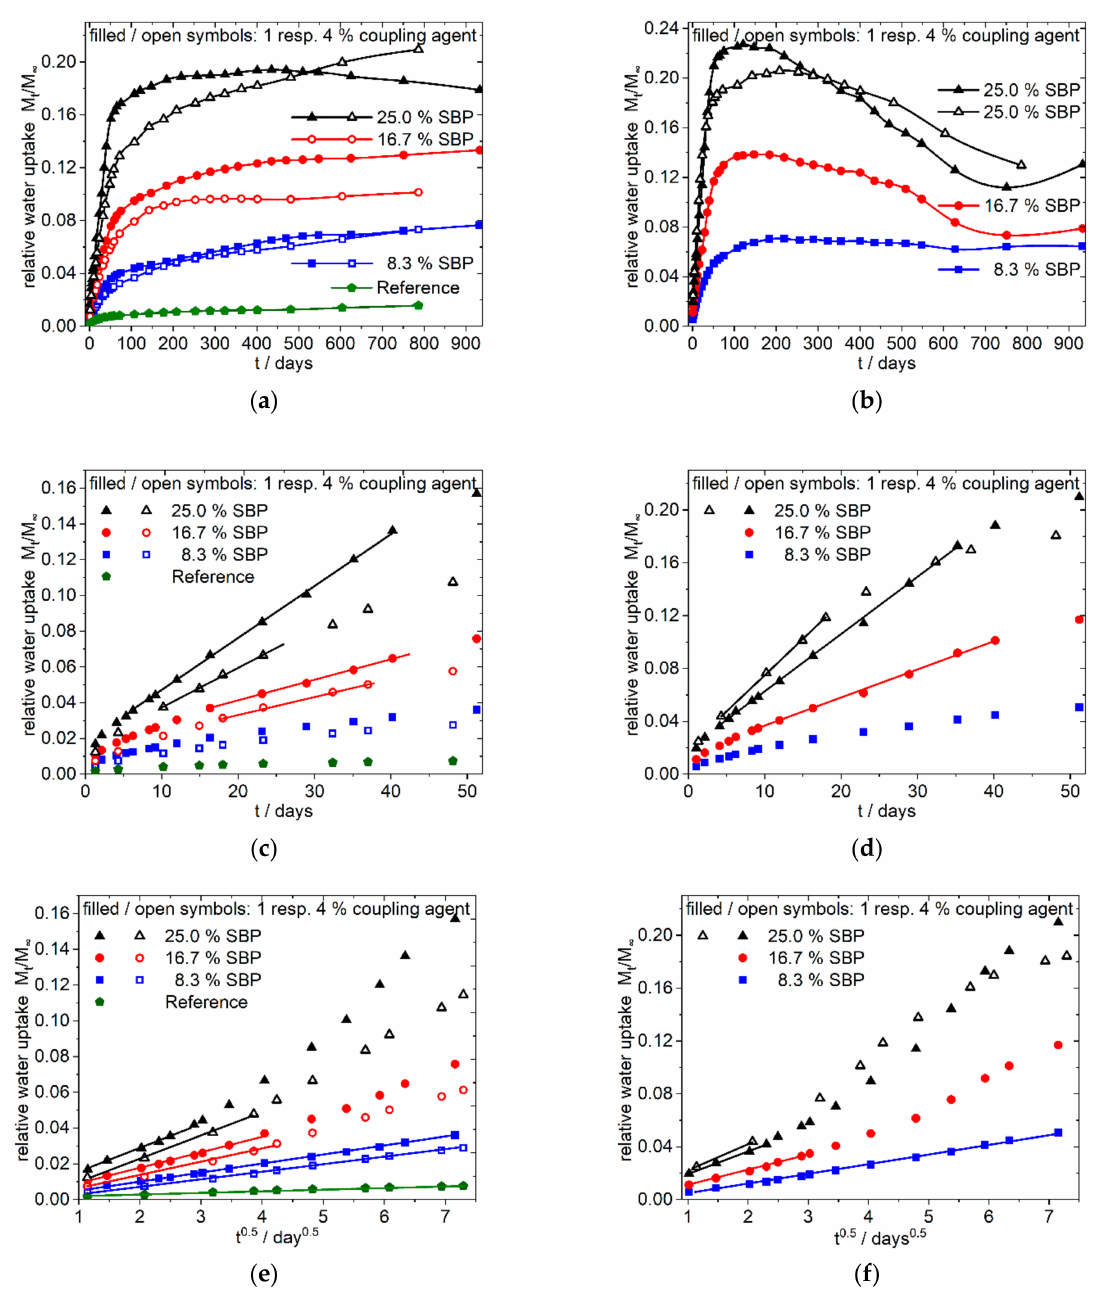
Figure 4. Water uptake of 9:1-f/c-8.3/16.7/25-1.0/4.0 Composites; fine type: ( a , c , e ); coarse type: ( b , d , f ); ( a , b ) overview, linear dependence from time; ( c , d ) enlargement of ( a , b ) for the first 50 days; ( e , f ) enlargement of the first 50 days of ( a , b ) showing the dependence of water uptake from the square root of time; filled and open symbols indicate: 1% resp. 4% of coupling agent per 10% of